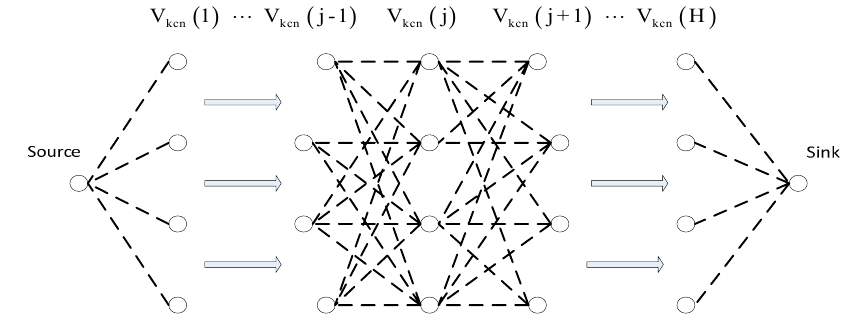
Figure 1. Collaborative Node Communication.